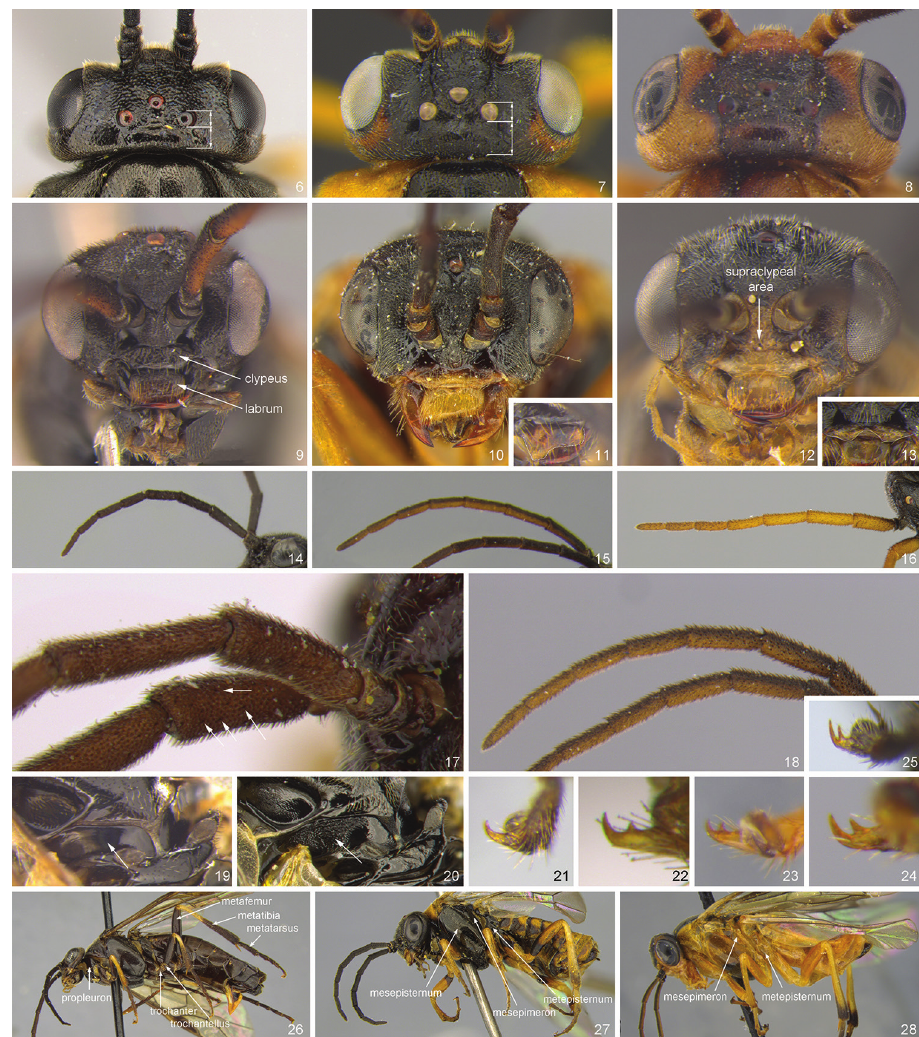
Figures 6–28. External characters used to identify Pristiphora species. 6 albitibia DEI-GISHym31514 7 testacea DEI-GISHym19770 8 pallida DEI-GISHym20845 9 bifida DEI-GISHym31512 10 groenblomi DEI-GISHym31602 11 retusa DEI-GISHym20965 12 abietina DEI-GISHym31225 13 malaisei DEI- GISHym19772 14 luteipes DEI-GISHym80038, flagellum 15 ruficornis DEI-GISHym31185, flagellum 16 armata DEI-GISHym11092 17 frigida NHRS-HEVA000005006, flagellum with barely visible stout black setae (arrows) 18 pusilla DEI-GISHym80050, flagellum with clearly visible stout black setae 19 ap- pendiculata DEI-GISHym31500, smooth mesopostnotum (arrow) 20 albitibia DEI-GISHym31516, matt mesopostnotum (arrow) 21 appendiculata DEI-GISHym31500, claw 22 opaca holotype 23 genicu- lata DEI-GISHym20961 24 depressa DEI-GISHym11043 25 bifida DEI-GISHym31507 26 robusta http://id.luomus.fi/GL.5197 27 biscalis DEI-GISHym11088 28 subbifida